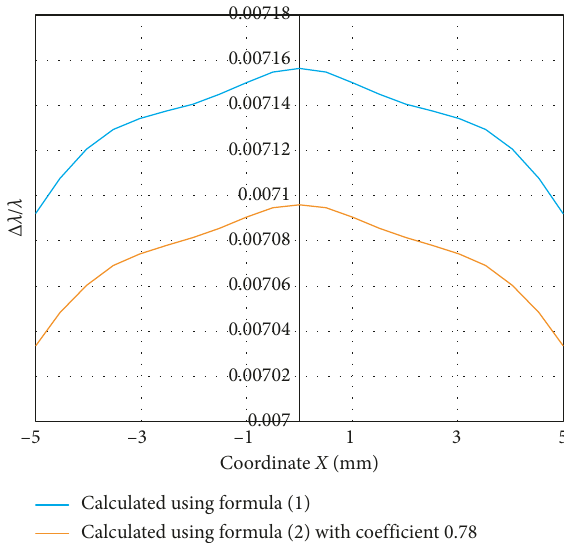
Figure 10: Estimated value the composite plies and attached to the surface through the ad- hesive